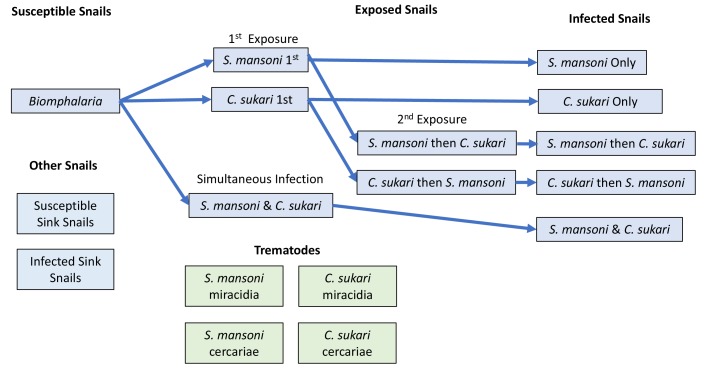
Conceptual diagram of the mathematical model.Each snail class includes both juvenile and adult age groups.